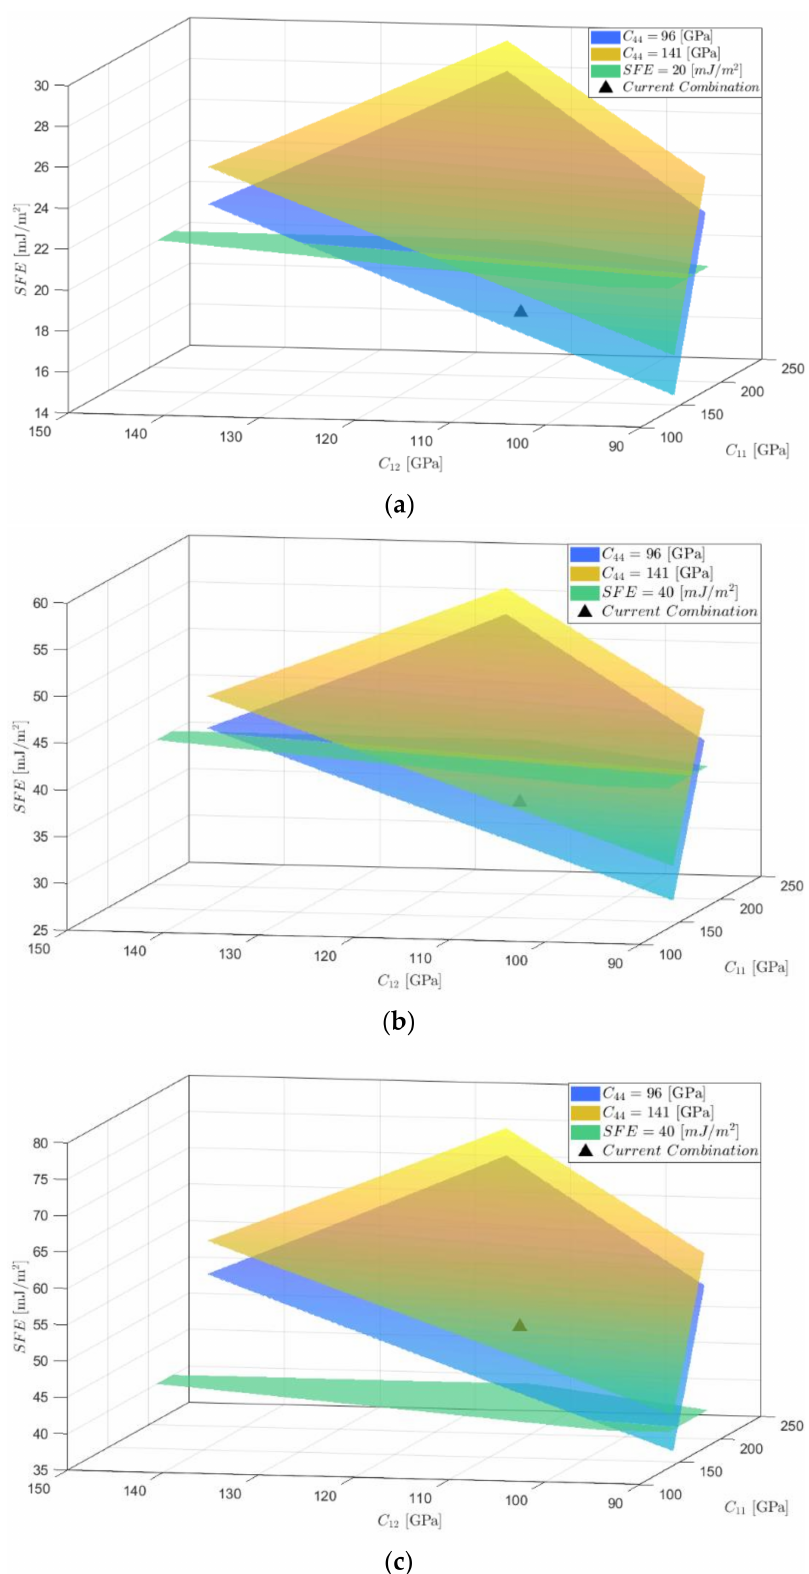
Figure 8. Variation in the elastic constants C 11 and C 12 for limit values of C 44 and the effect on the SFE for ( a ) Fe-22Mn-0.9C-0Al, ( b ) Fe-22Mn-0.9C-3Al and ( c )